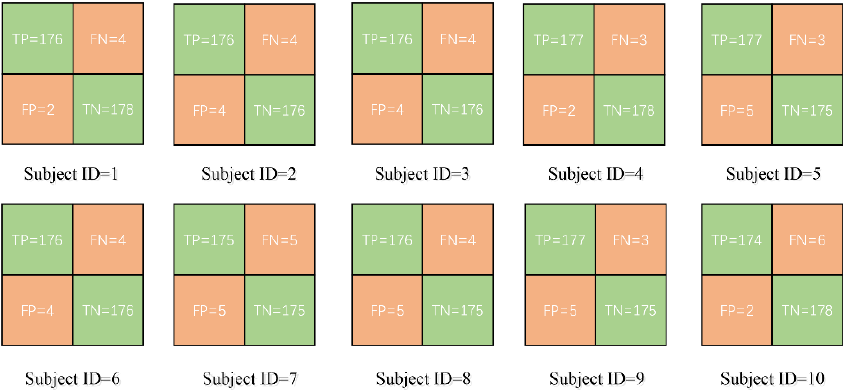
Figure 7. Confusion matrices for leave-one-subject-out fatigue recognition with fine KNN.